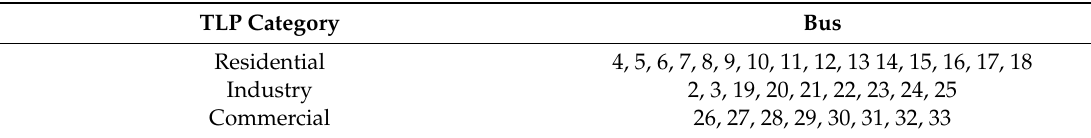
Table 5. The TLP categories used for the IEEE 33 -bus system and their bus